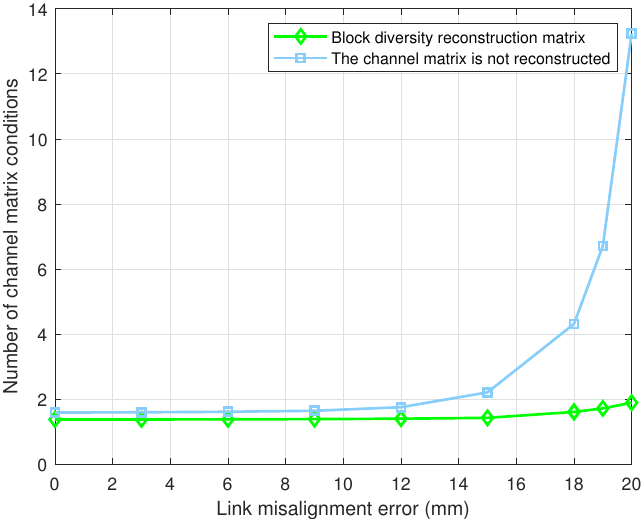
Figure 7. The conditions number of H versus the link misalignment error (cid:52) x in turbulent environment. After using the block diversity technique, the condition number of the channel matrix is reduced, but the channel correlation is still increasing with the increase of the link mis- alignment error. In addition, in the case of large link misalignment, part of the received optical signal will be lost. Figure 8 shows the distribution of imaging spots under different link misalignment degrees. By applying diversity techniques to the underwater optical massive MIMO system blocks, the imaging within the same diversity combination can be combined into a large spot. Figure 8a shows the spot distribution when the link mis- alignment degree is small. Due to the adopted block diversity technology, the correlation between sub-channels in the same diversity combination does not need to be considered.